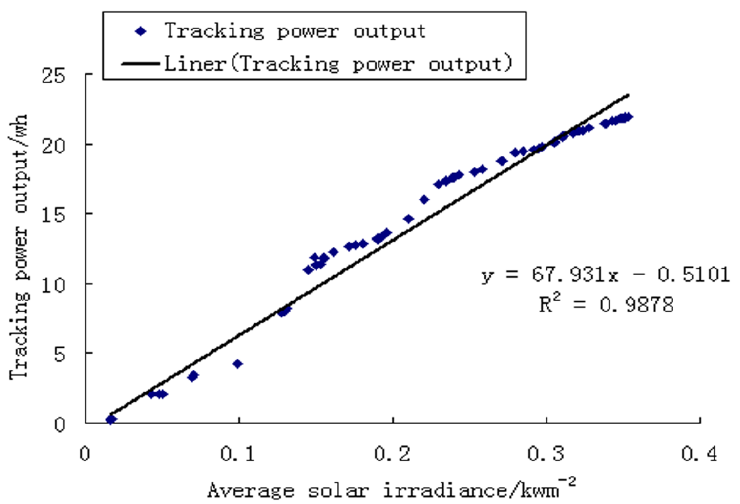
Figure 10. Linear regression between average solar irradiance (kW/m 2 ) and fixed solar output (Wh).